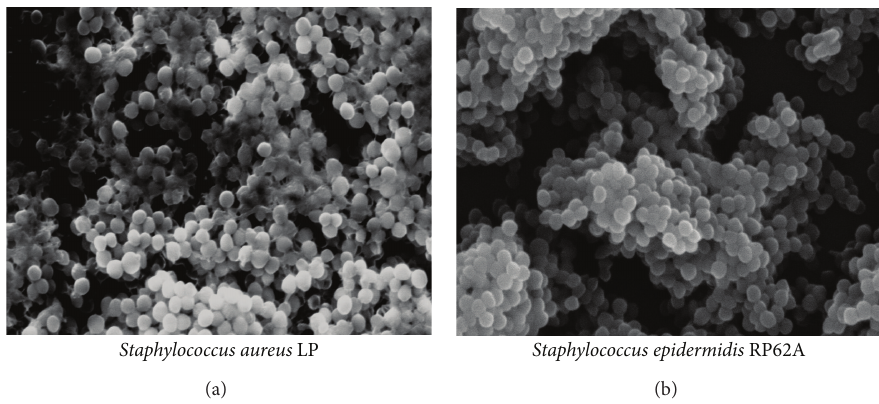
Figure 3: Scanning electron microscopy images of biofilm produced by S. aureus LP [116] and S. epidermidis RP62A [117] in the air liquid interphase of TSB-glucose medium after 24 h incubation at 37 ∘ C ((a) and (b): magnification, × 5 000).